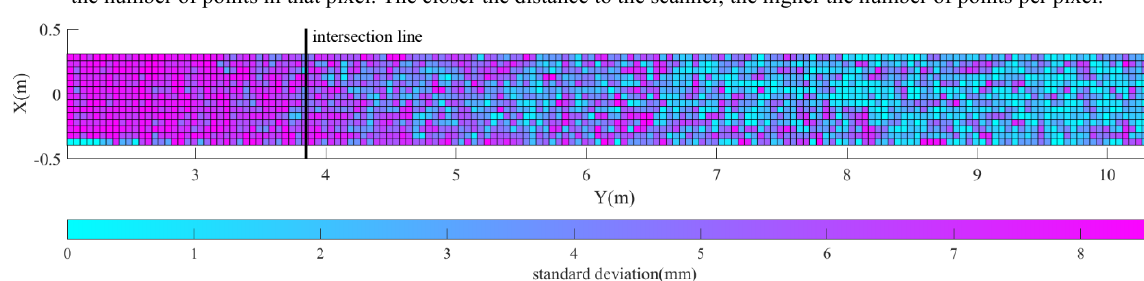
Figure 8. Raster image of Slope 1, colored by number of points in each pixel . The attribute of each pixel is determined by counting the number of points in that pixel. The closer the distance to the scanner, the higher the number of points per pixel.